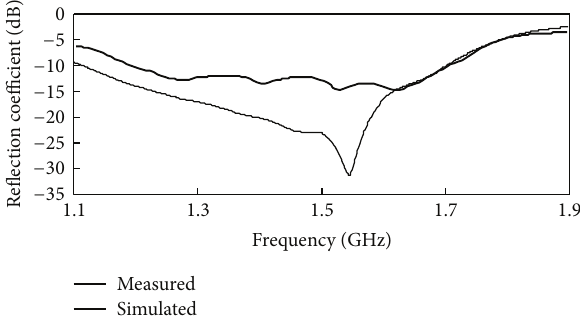
Figure 12: Comparison between measured and simulated results of reflection coefficient.